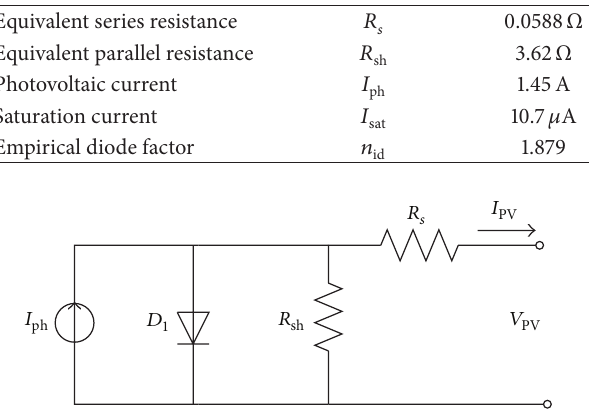
Table 4: Simulation parameters for CSSS-90A.